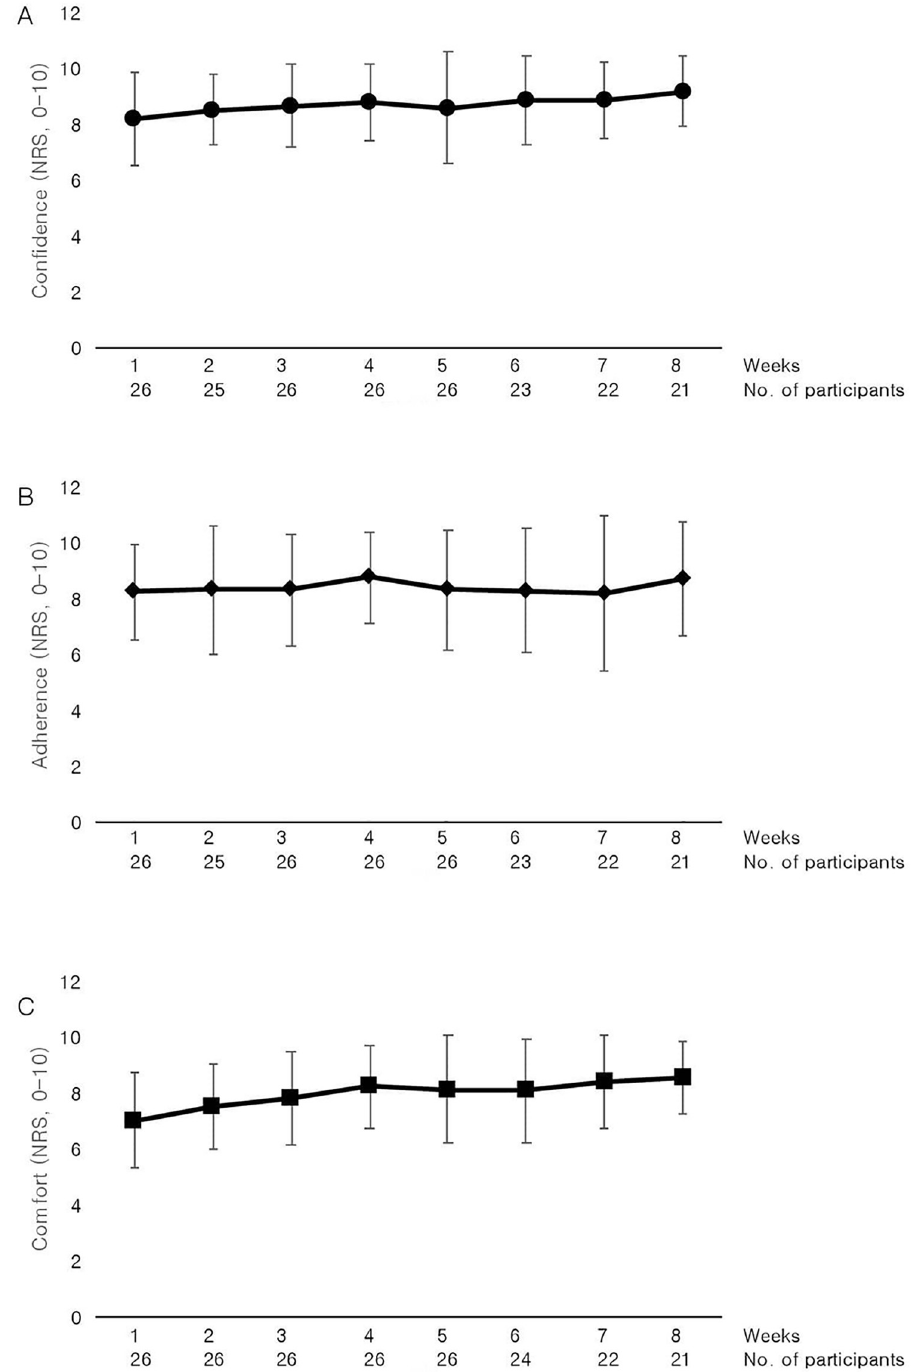
Fig 3. Mean and standard deviation weekly numeric rating scale (NRS) scores for confidence (A), adherence (B) and comfort (C). Higher scores indicate greater confidence levels whilst performing daily tasks when wearing the brace (A), greater adherence to wearing the brace every day during daily activities (B), greater comfort when wearing the brace; and vice versa for lower scores.